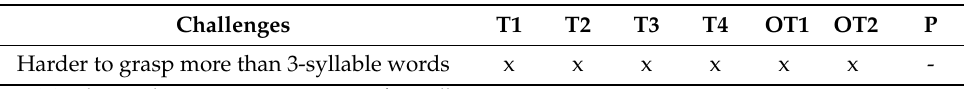
Table 9. Harder to grasp more than 3-syllable